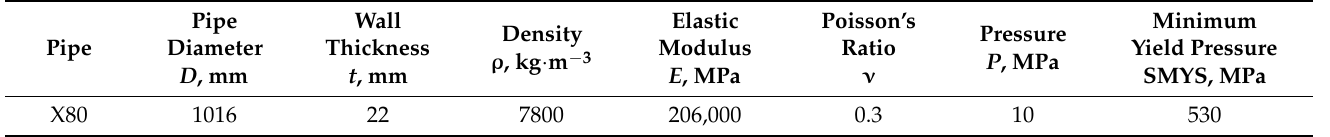
Figure 4. True stress – strain curve of X80 steel. Table 2. Basic parameters of pipeline model. Table 2. Basic parameters of pipeline model.